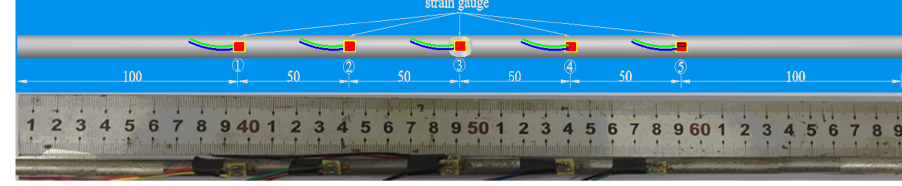
Figure 2. Arrangement of strain gauges on the notched specimen (unit: mm).